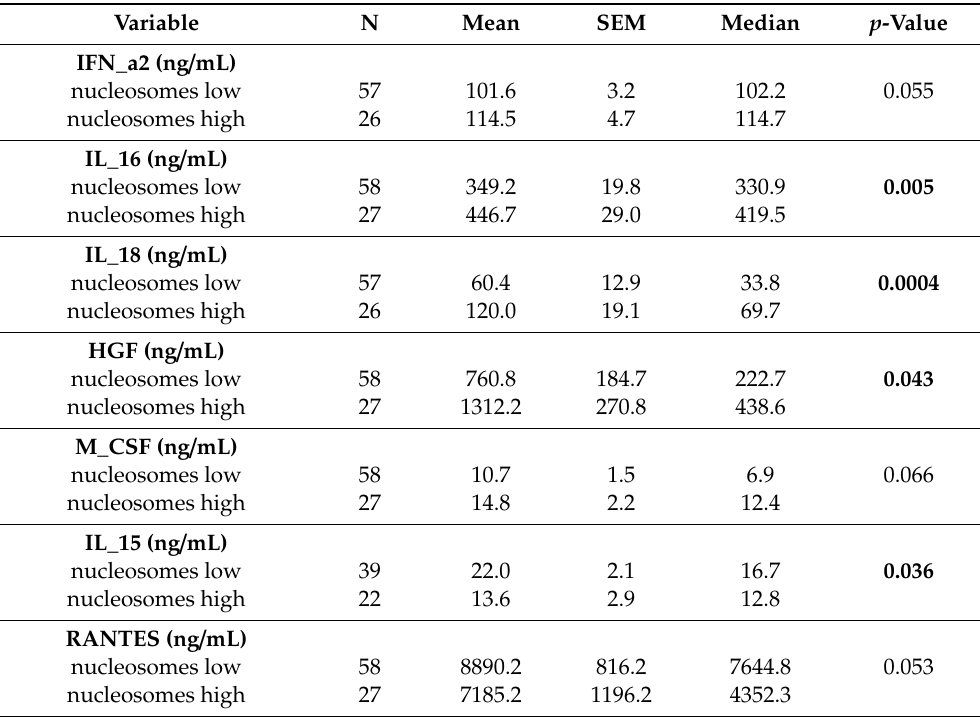
Table 3. Association between nucleosomes and plasma cytokines.